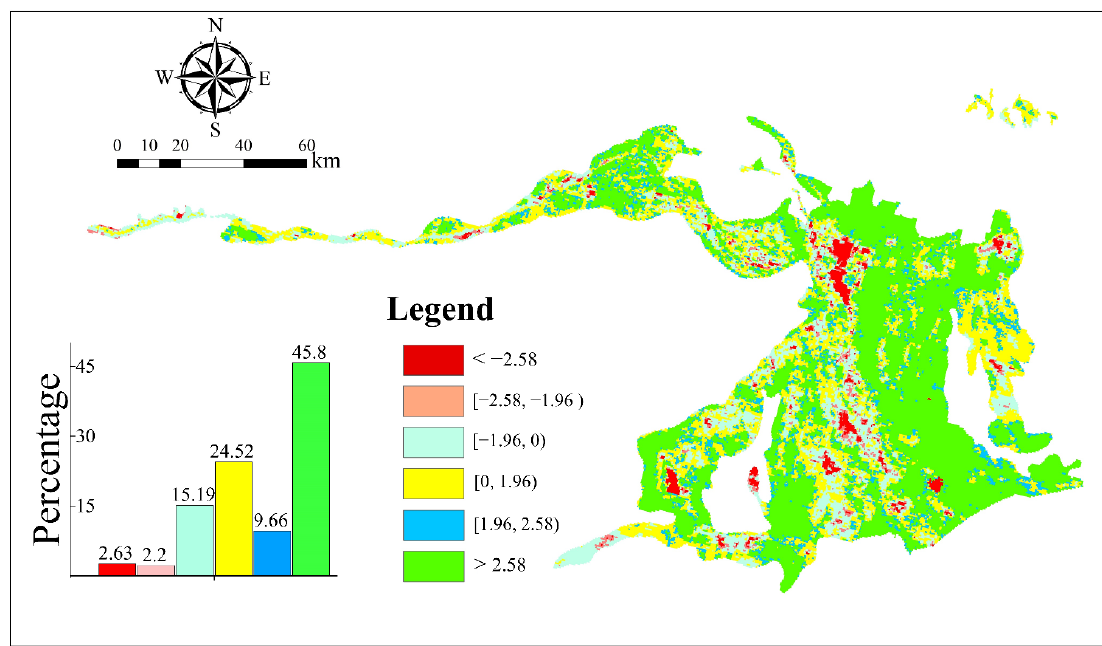
Figure 6. Ecological environment quality grade.